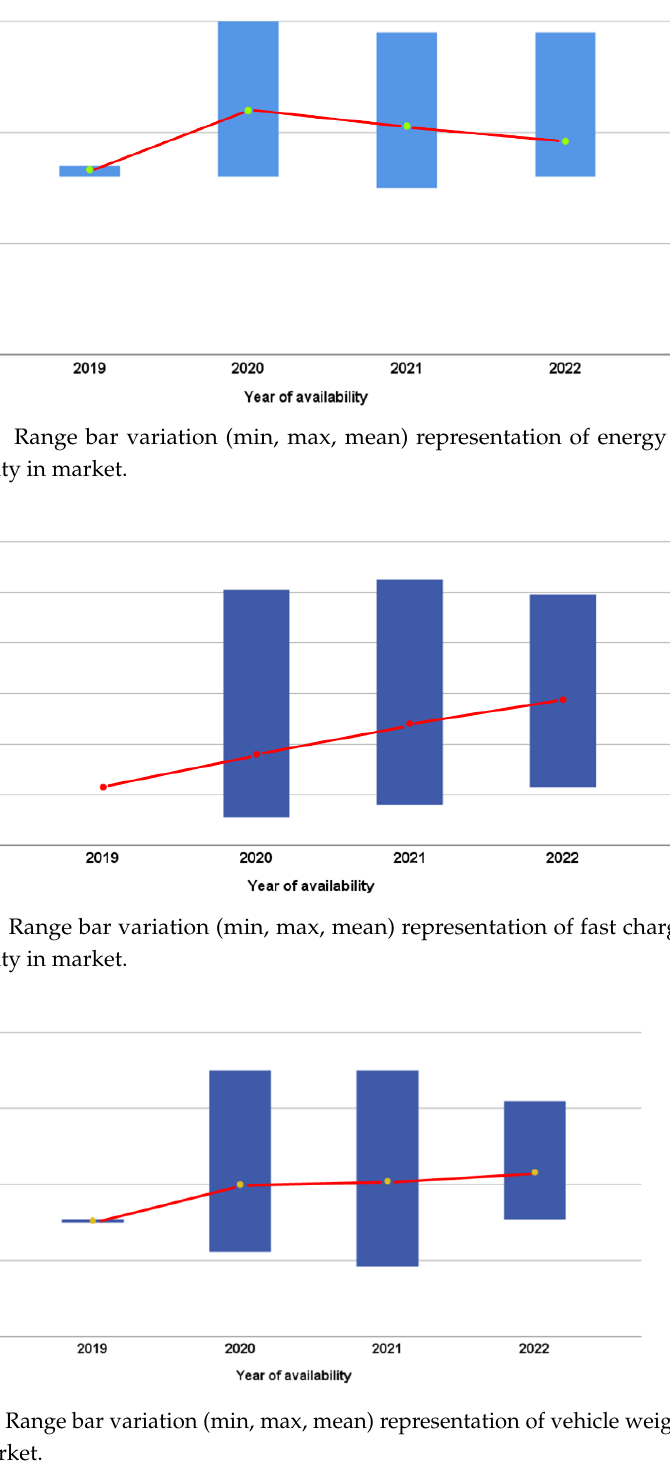
Figure 10. Range bar variation (min, max, mean) representation of autonomy vs. brands of cars.